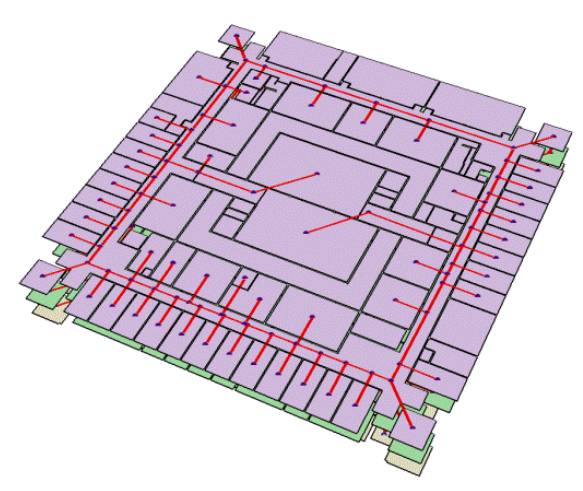
Figure 5. Vector and node